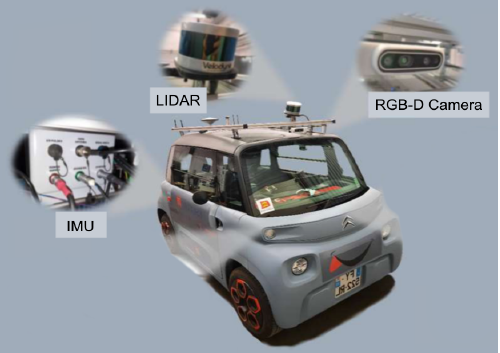
Figure 3. The Citroën AMI modified by the ESIGELEC for data recordings.